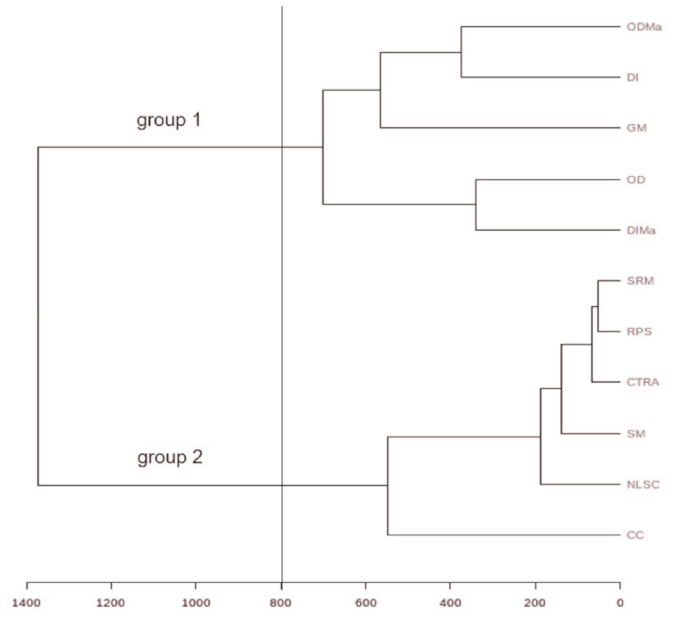
Figure 4. Hierarchical group analysis (HCA) of the 11 populations of